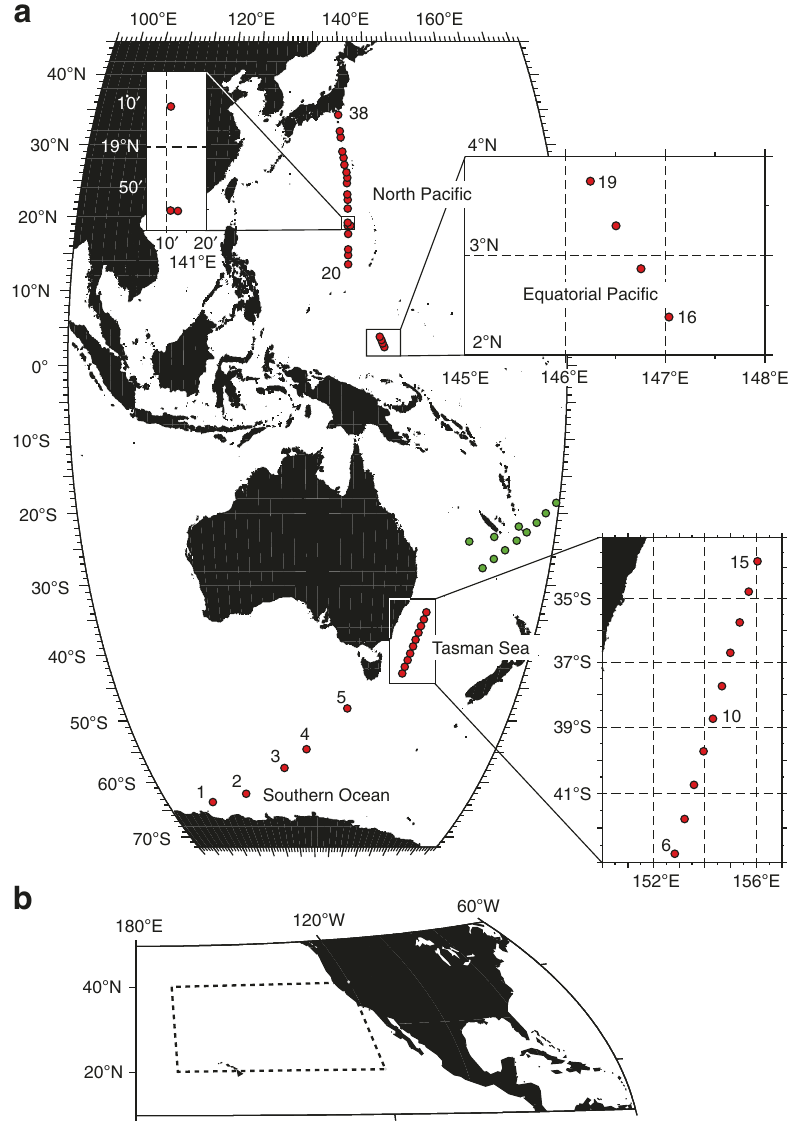
Fig. 1 Transoceanic microplastic surveys in the present study. The survey stations along a meridional transect from Sta. 1 to Sta. 38 are shown by red dots ( a ). Areas with a dense network of stations are enlarged in the inset maps. The stations used in Reisser et al. 22 are shown by green dots, which complement the large gap between stations 15 and 16. The weight concentrations of microplastics in Goldstein et al. 3 were also used in the present study within the area surrounded by the broken lines ( b